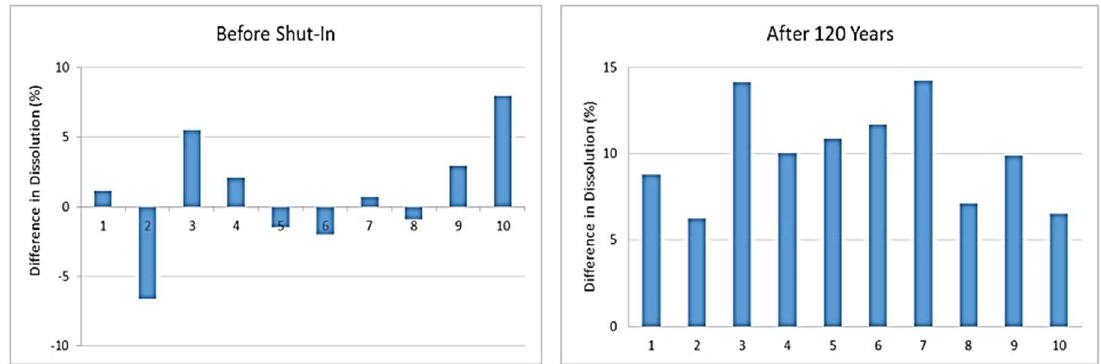
Figure 7. Increase/decrease in permeability for different permeability heterogeneity data.